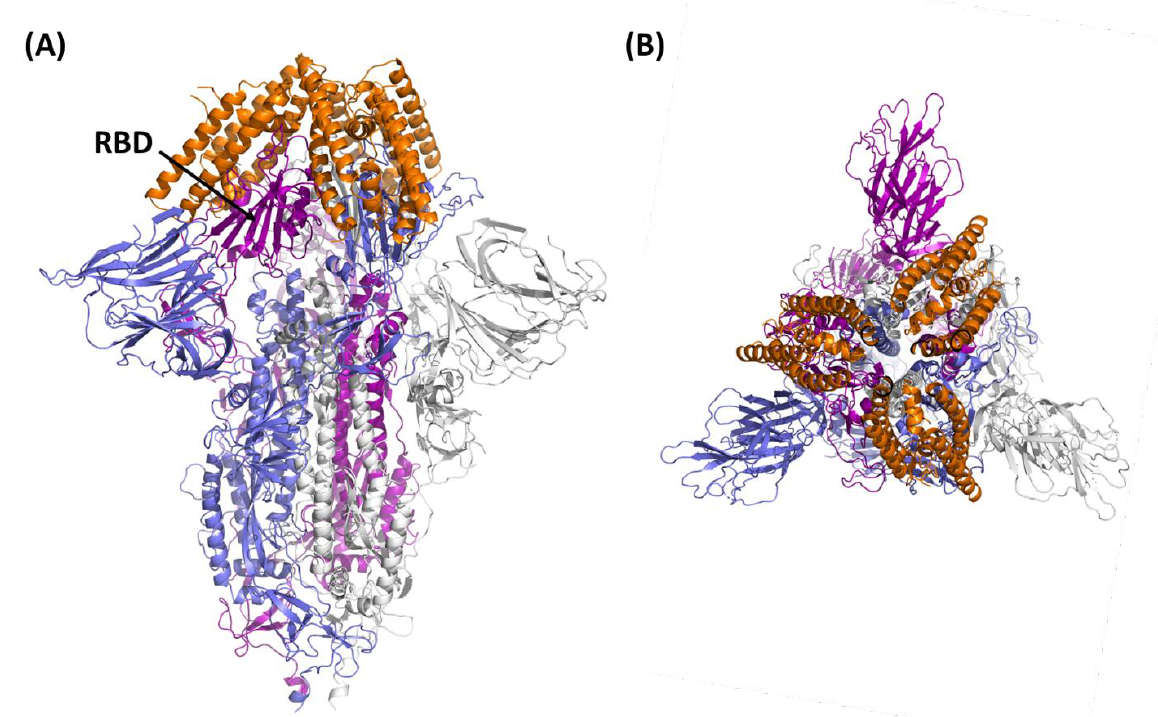
Figure 7. Cartoon representation of the spike trimer (closed conformation) in complex with S-plug3. The positions of S-plug3 molecules (orange) on the spike protein were determined upon superposition of RBD of our minimised S-plug3–RBD complex on the RBD of the entire S protein (pdb code 6m0j). ( A , B ) panels report side and top views, respectively.